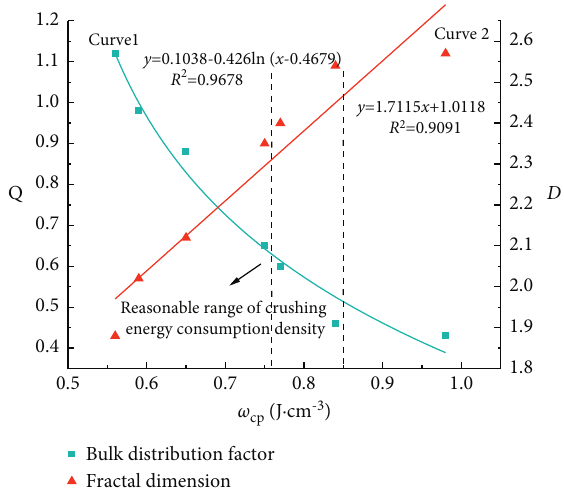
Figure 14: The relationship diagram for determining the rea- sonable range of crushing energy consumption density.